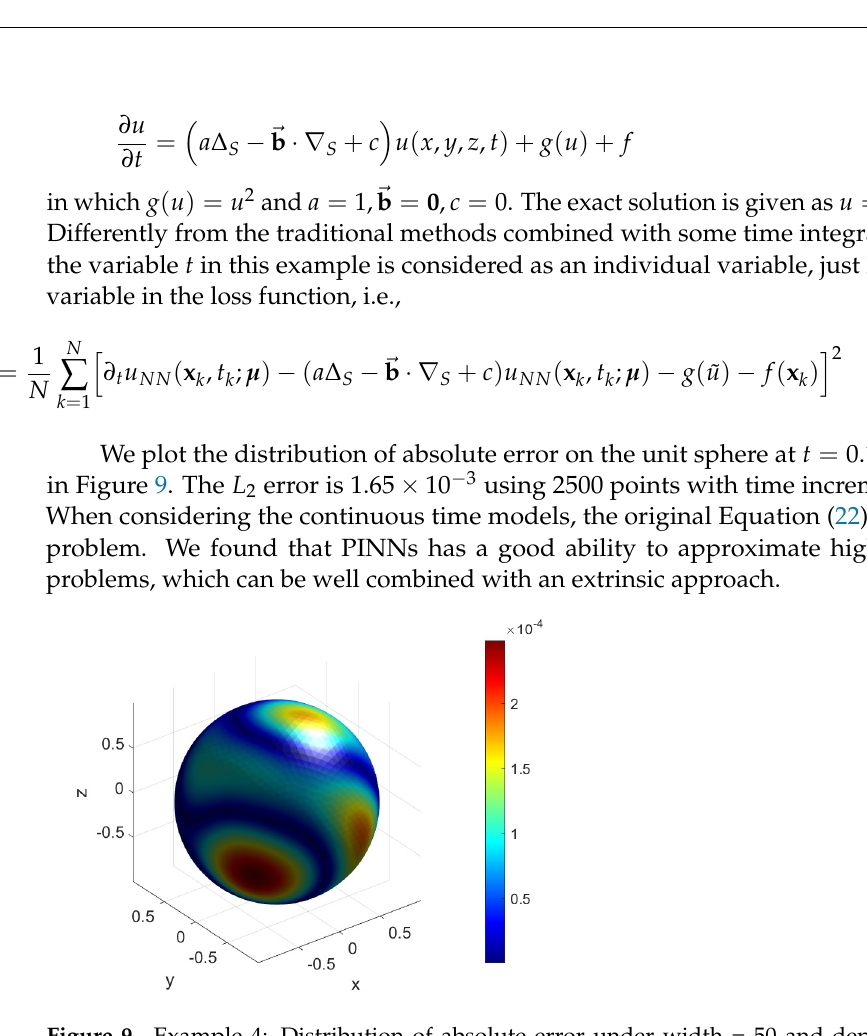
Figure 9. Example 4: Distribution of absolute error under width = 50 and depth = 4 for time- dependent nonlinear problems (22) on the unit